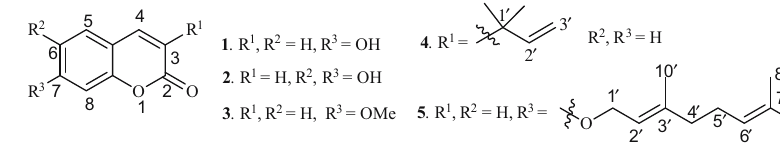
Figure 1: Structures of simple coumarins of Casimiroa